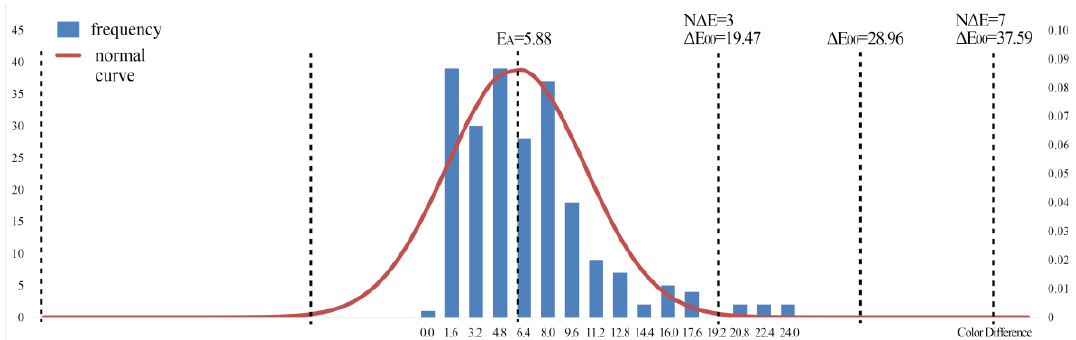
Figure 3. Normal distribution of color difference between C-A6 and S-A6. The color difference between C-A6 and S-A6 obeyed the normal distribution N (5.88, 4.53 2 ). When the color difference a certain color and S-A6 was 19.47, NΔE was 3; when the color difference between a certain color and S-A6 was 37.59, NΔE was 7. Because the color difference was a positive number, the negative number had no reference value.